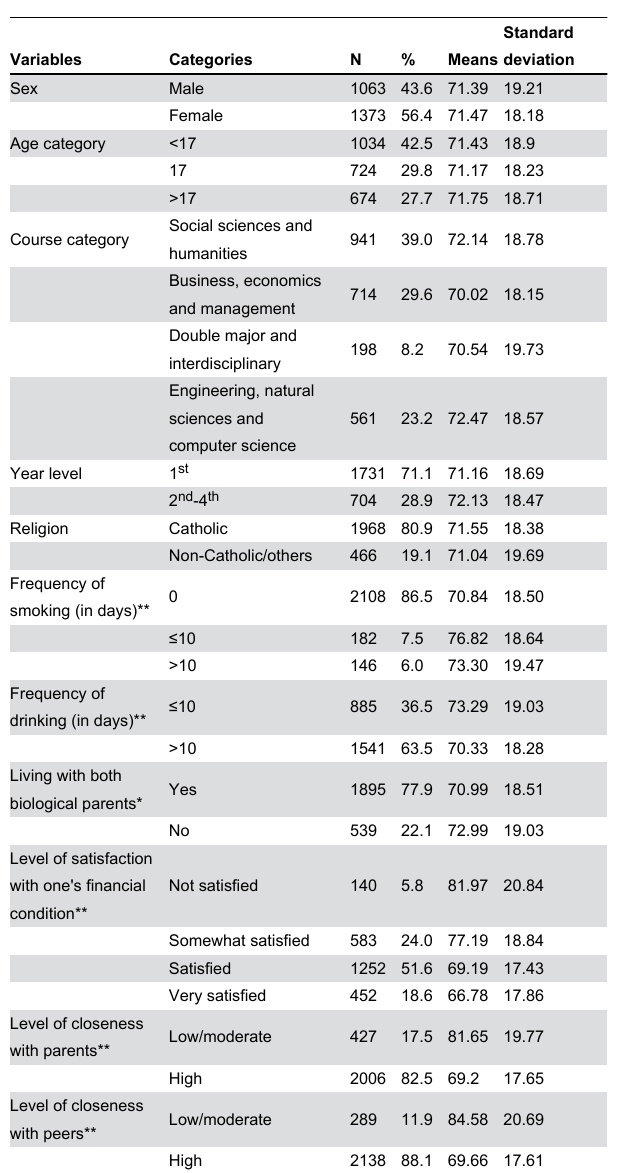
Table 3. Means, F-values and p-values for depressive symptoms sub-scale scores by selected social and demographic